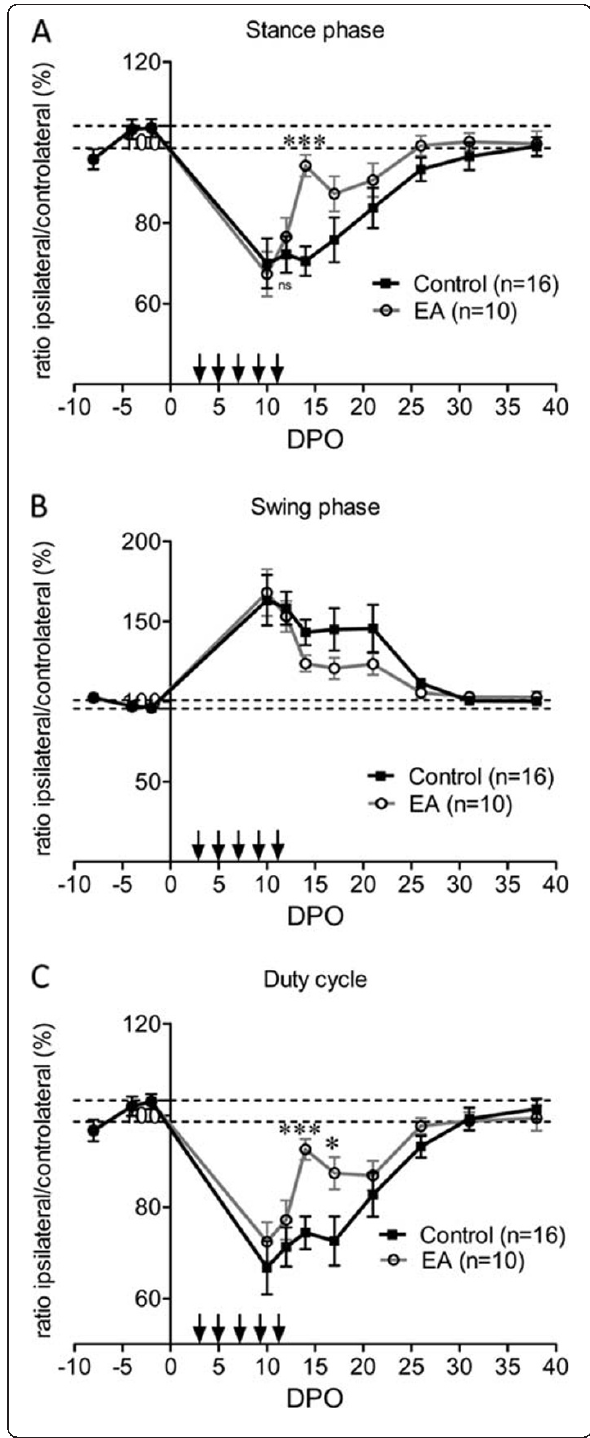
Figure 6 Analysis of dynamic parameters of gait. ( A ) Duration of the stance phase (period in which the paw is in contact with the floor during each step cycle). Electro-acupuncture (EA) induced a significant recovery at 14 DPO; time for full recovery was not modified (between 31 – 38 DPO). ( B ) Duration of the swing phase (period in which the paw is not in contact with the floor during each step cycle). Electro-acupuncture did not significantly affect this parameter at any time. ( C ) Duty cycle (the stance phase/swing phase+stance phase) showed a full recovery between 31 – 38 DPO in control mice. Electro-acupuncture induced a transient recovery at 14 and 17 DPO. Time for full recovery was not changed. * p<0.05, *** p<0.001 (ANOVA).